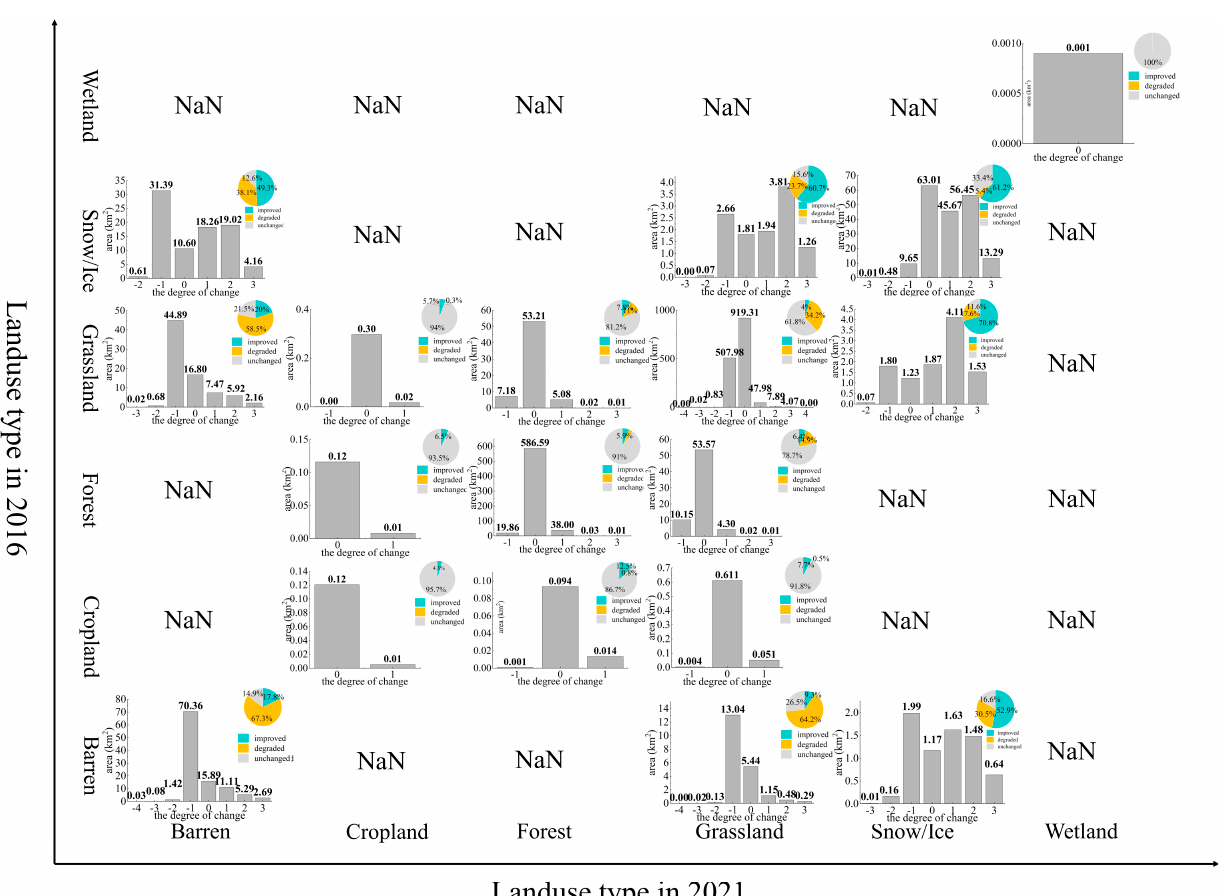
Figure 12. Statistics on the relationship between land use type change and ecological environment quality change from 2016 to 2021. NaN means there are no such observations. Taking the land use as barren in 2016 and as barren in 2021 as an example, we can see the shift area of the ecological class change caused by the barren–barren shift approach in the bar chart. At the same time, we can see the area proportion of ecological environment improvement or deterioration caused by the change in land use mode in the pie chart (bo tt om left corner of the fi gure).